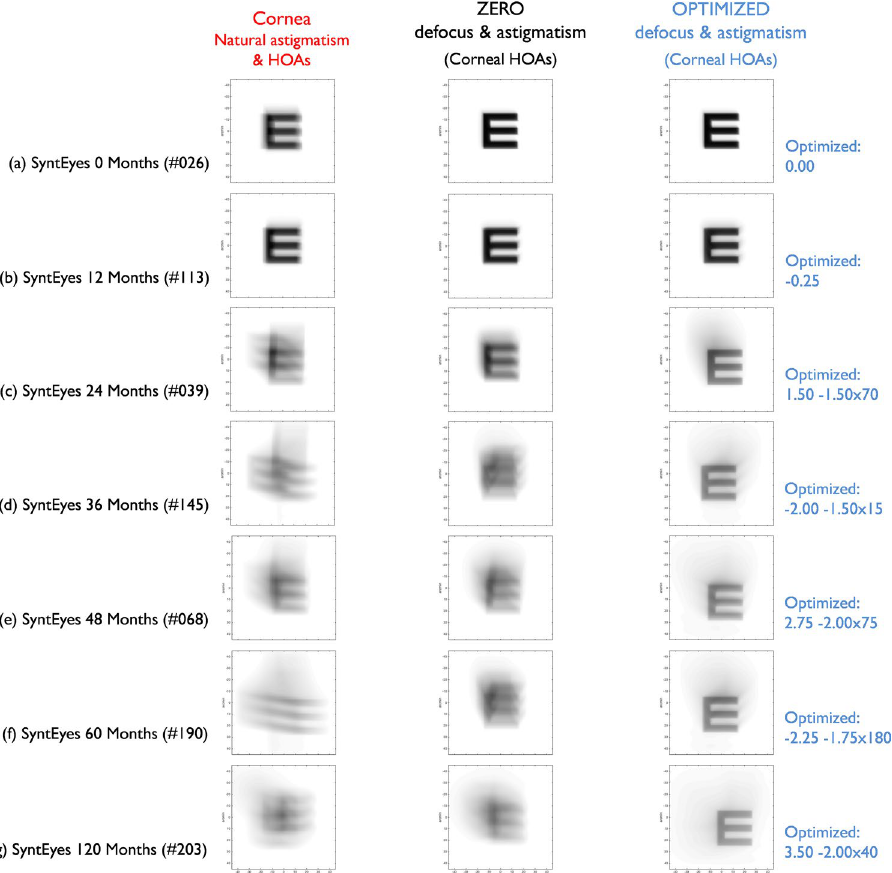
Figure 3. Theoretical simulations of 30 arc-min Snellen E-letters (4-mm pupil) for representative examples of each SyntEye group. Left column: convolved letter with the astigmatism and natural aberrations of the cornea. Middle column: convolved letter after full cancellation of defocus and astigmatism. Right column: convolved letter with the sphero-cylindrical correction that produced the best optical quality (peak Visual